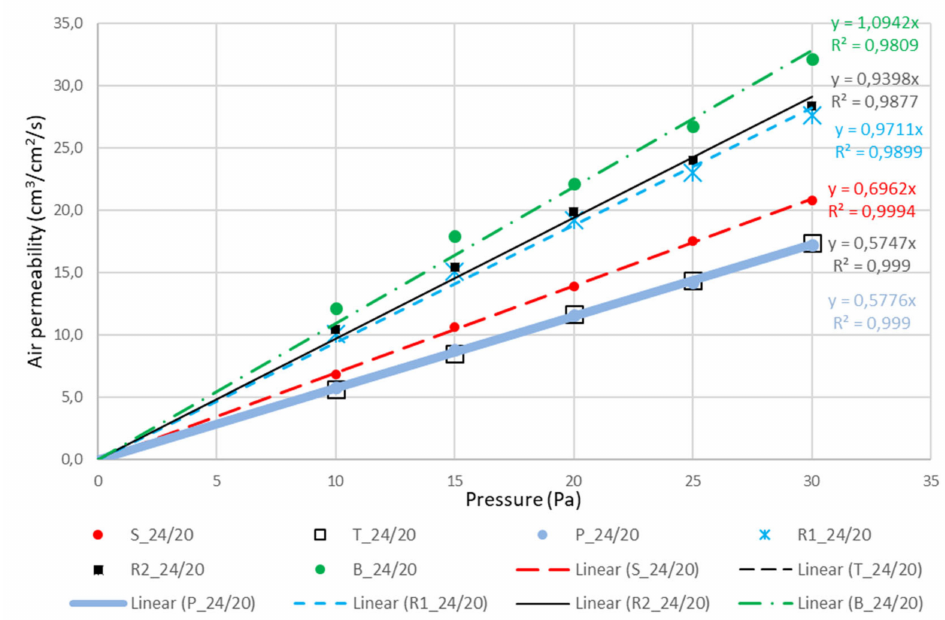
Figure 6. Linear regression of curves air permeability—pressure for the samples in densities 24 / 20. This time the curves for plain and twill are covering each